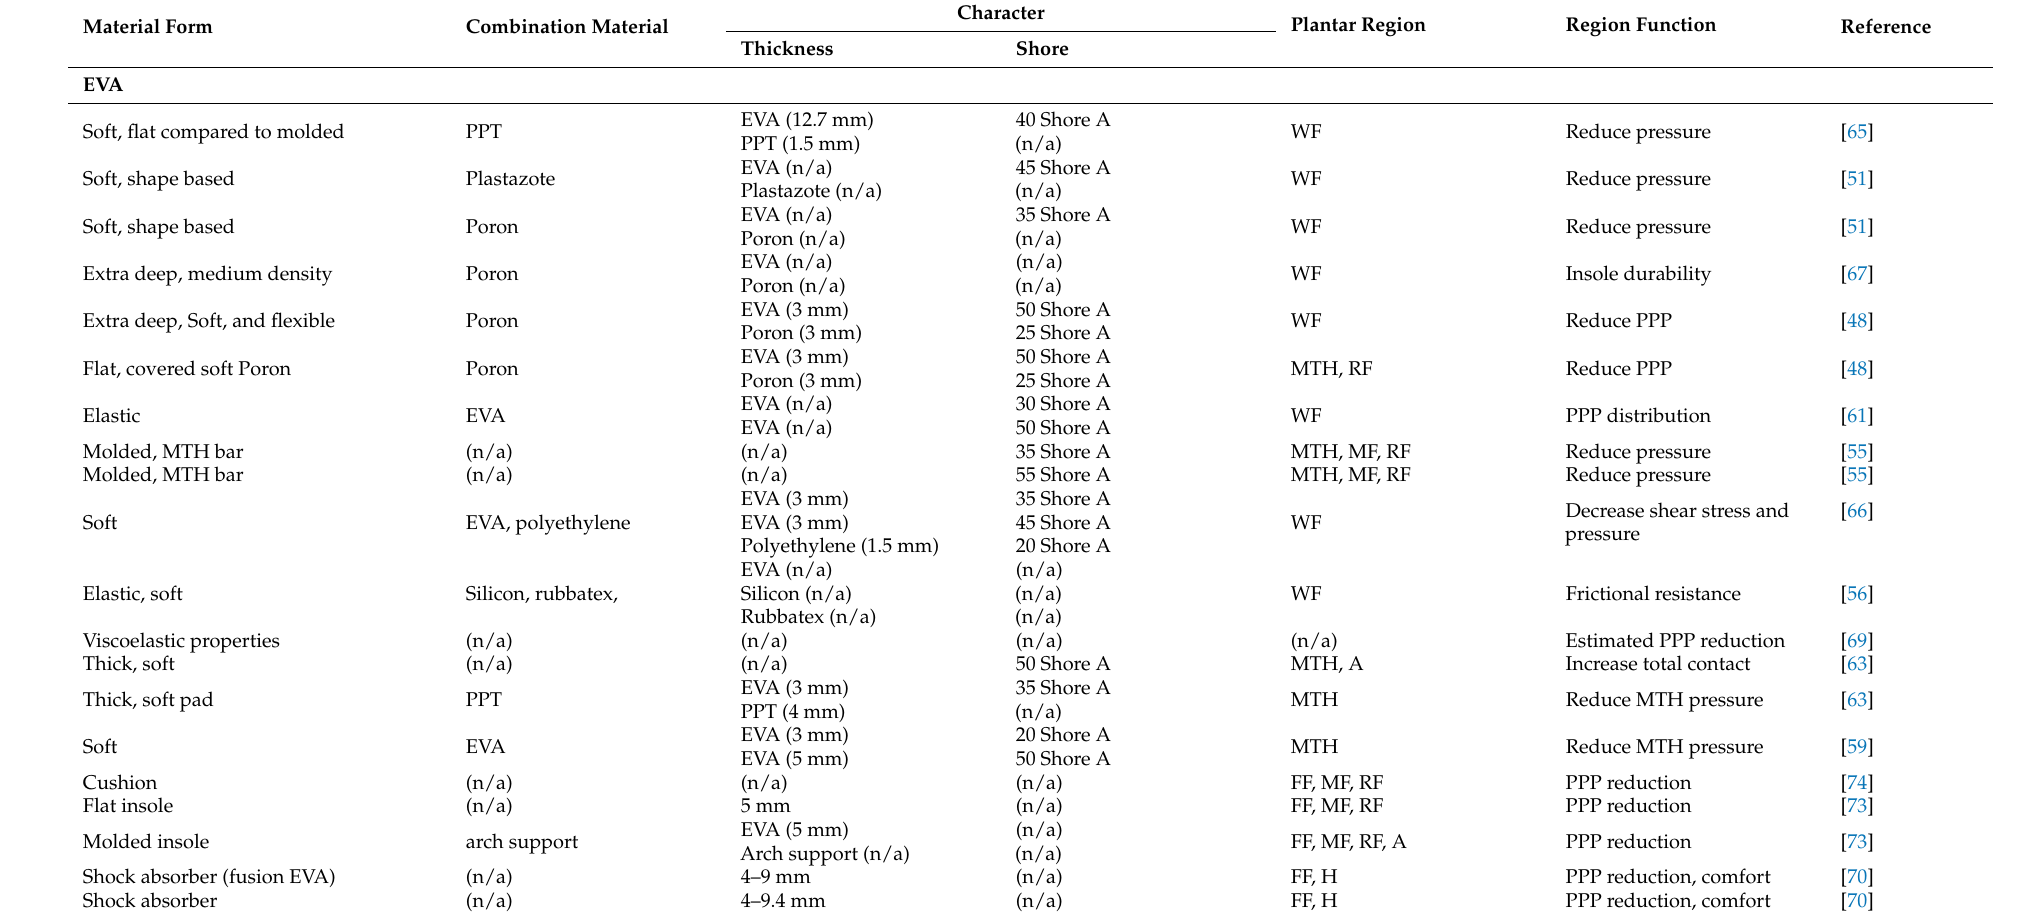
Table 6. Insole materials based on their character and function used in plantar